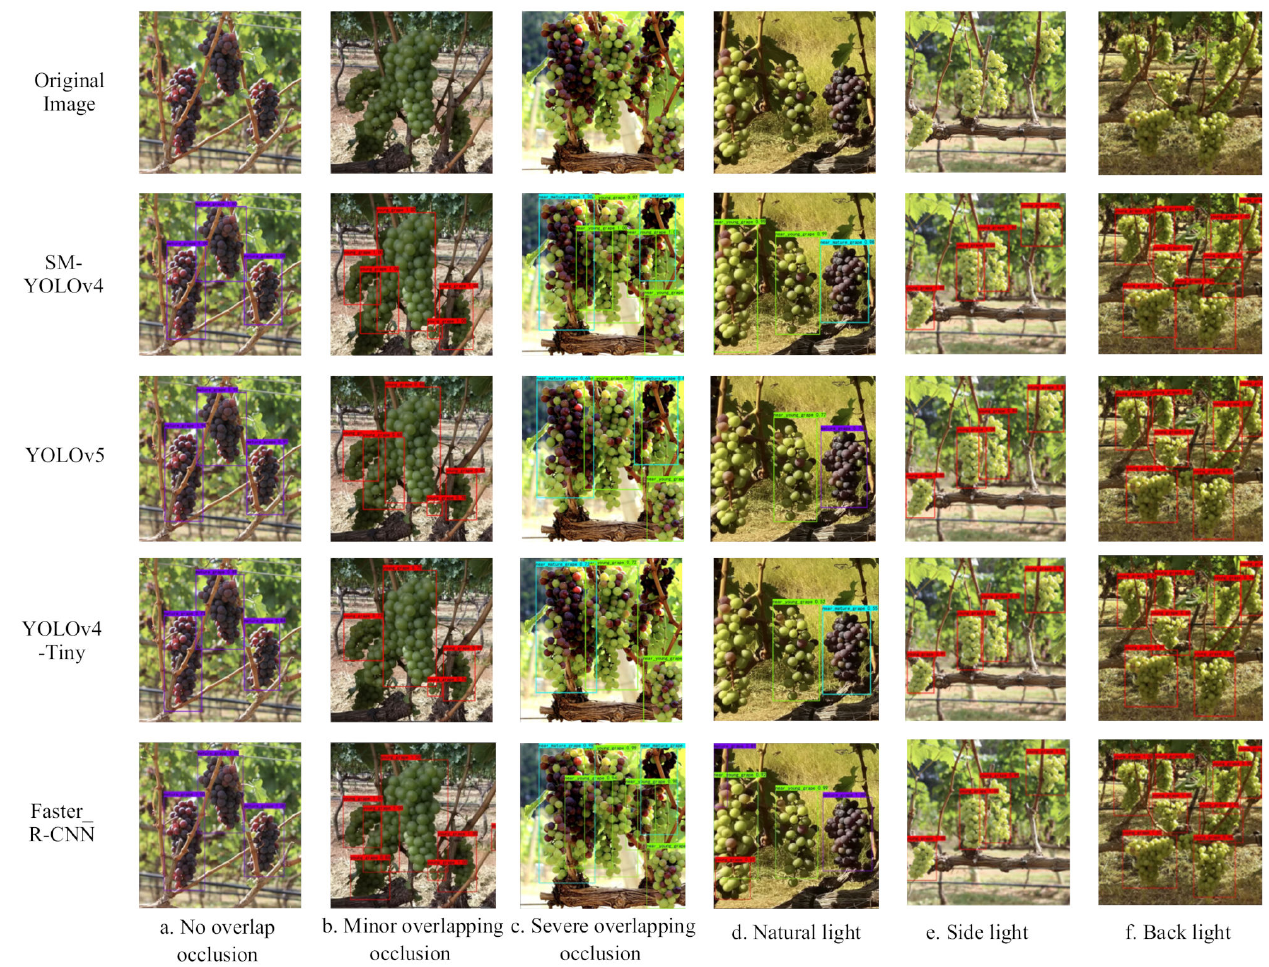
Figure 9. Detection of grape maturity with different models under different conditions. Among them, the correct color of detection frame should comply with the following regulations, the immature stage of full green was marked as young_ grape (red box), the immature stage of a small number of fruit grains turning purple was marked as near_ young_ grape (green box), the near mature stage of most fruit grains turning purple was marked as near_ mature_ grape (blue box), and the mature stage of full purple was marked as nature_ grape (purple